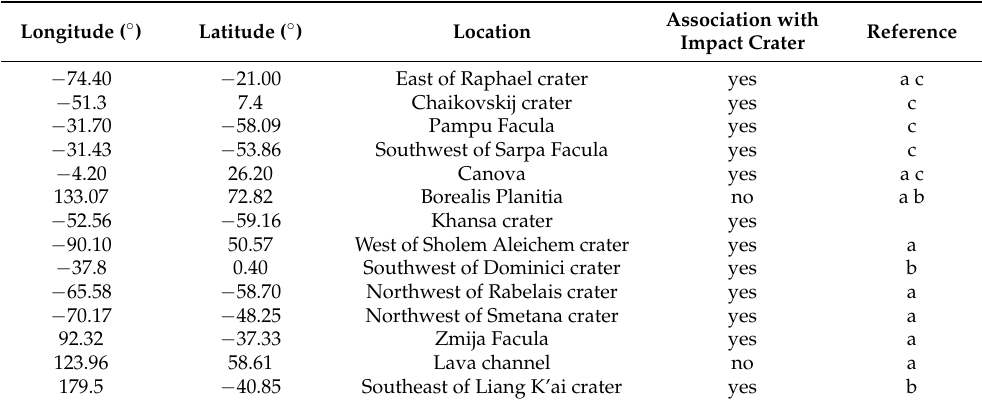
Table 1. Information of pitted-ground terrains that are interpreted as pyroclastic vents in this study. Longitude (°) Latitude (°) Location